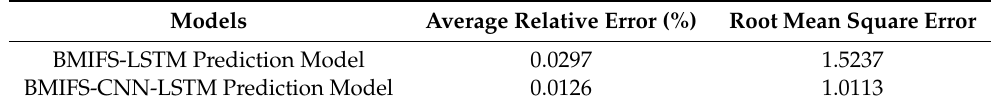
Table 4. Comparison of model error